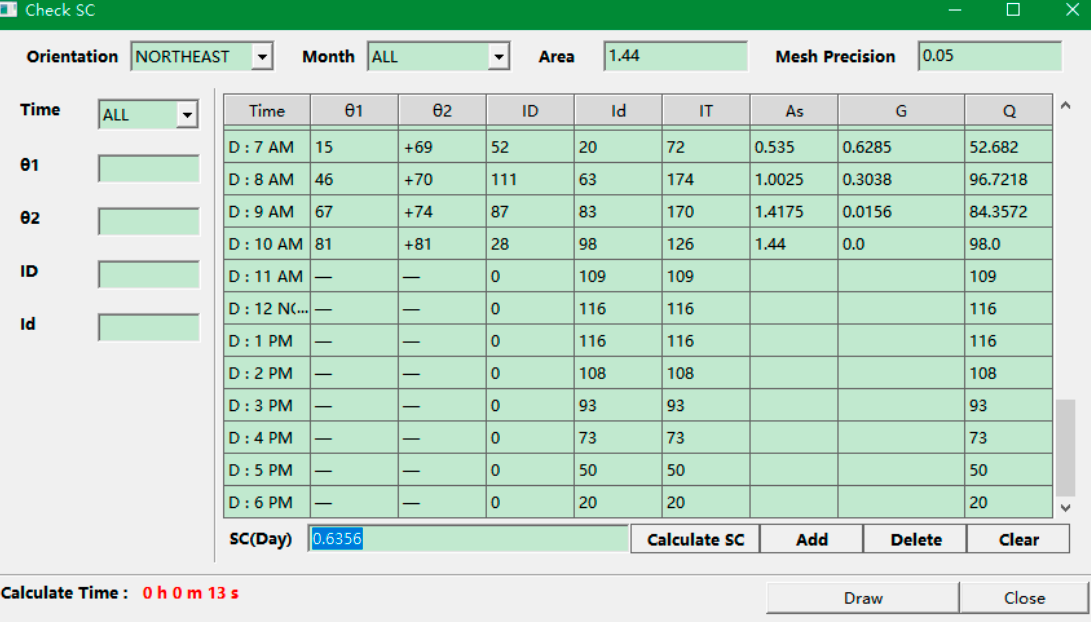
Figure 16. SC2 calculation by using the proposed method.